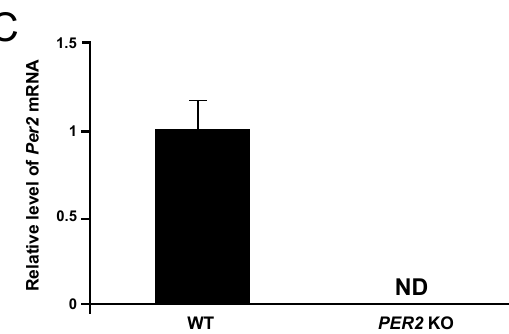
Figure 4. Differences in mRNA expressions of Runx2 ( A ), ALP ( B ), and Per2 ( C ) genes between tibial bone marrows of WT and Per2 KO mice in 405 nm LLLT using MILNS. The data are mean ± SEM ( n = 3). Statistical significant is indicated by *** p < 0.001. ND, no detection.